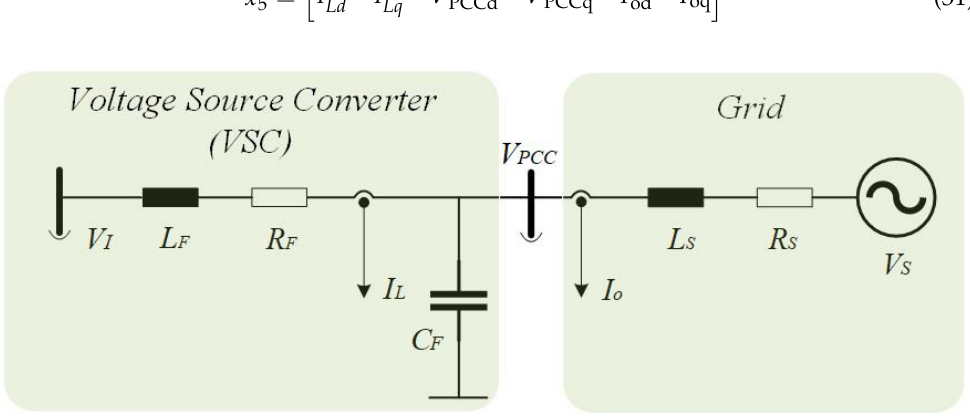
Figure 6. LC filter and grid impedance circuit in Figure